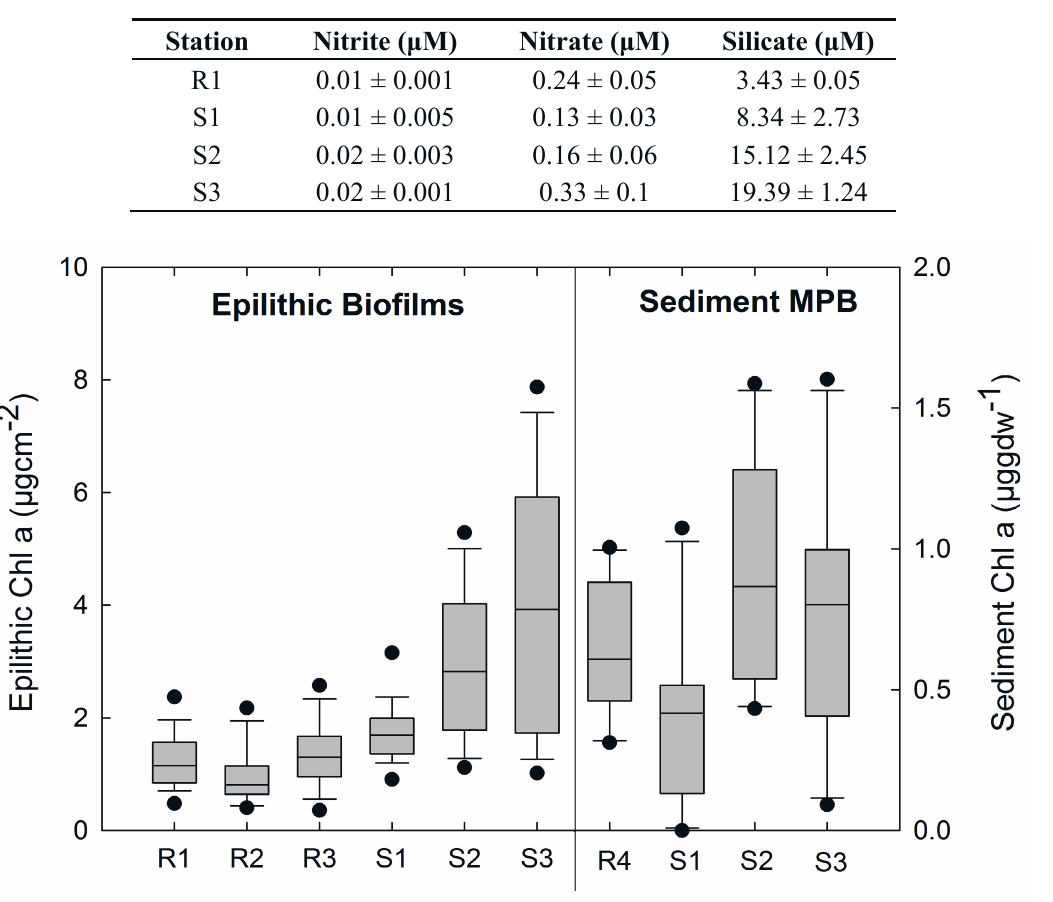
Figure 2. Chl a concentration of epilithic biofilms and chl a content of the microphytobenthos (MPB) in surface sediment sampled along a CO 2 gradient off Vulcano, Italy (median = horizontal line, 25th and 75th percentiles = vertical boxes, 10th and 90th percentiles = whiskers and dots = min/max values, epilithic; n = 30 per station, sediment; n = 10 per